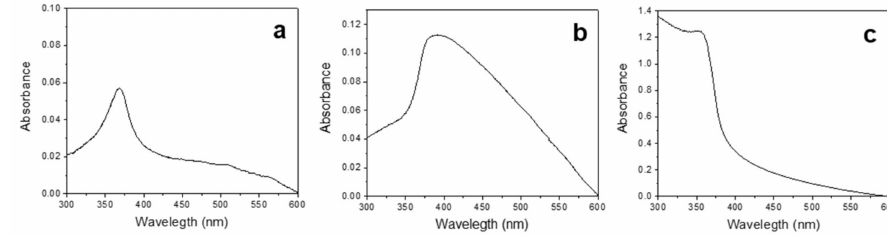
Figure 1. UV/Vis spectra of ( a ) CTAB-, ( b ) PDDA-, and ( c ) PSS-stabilized